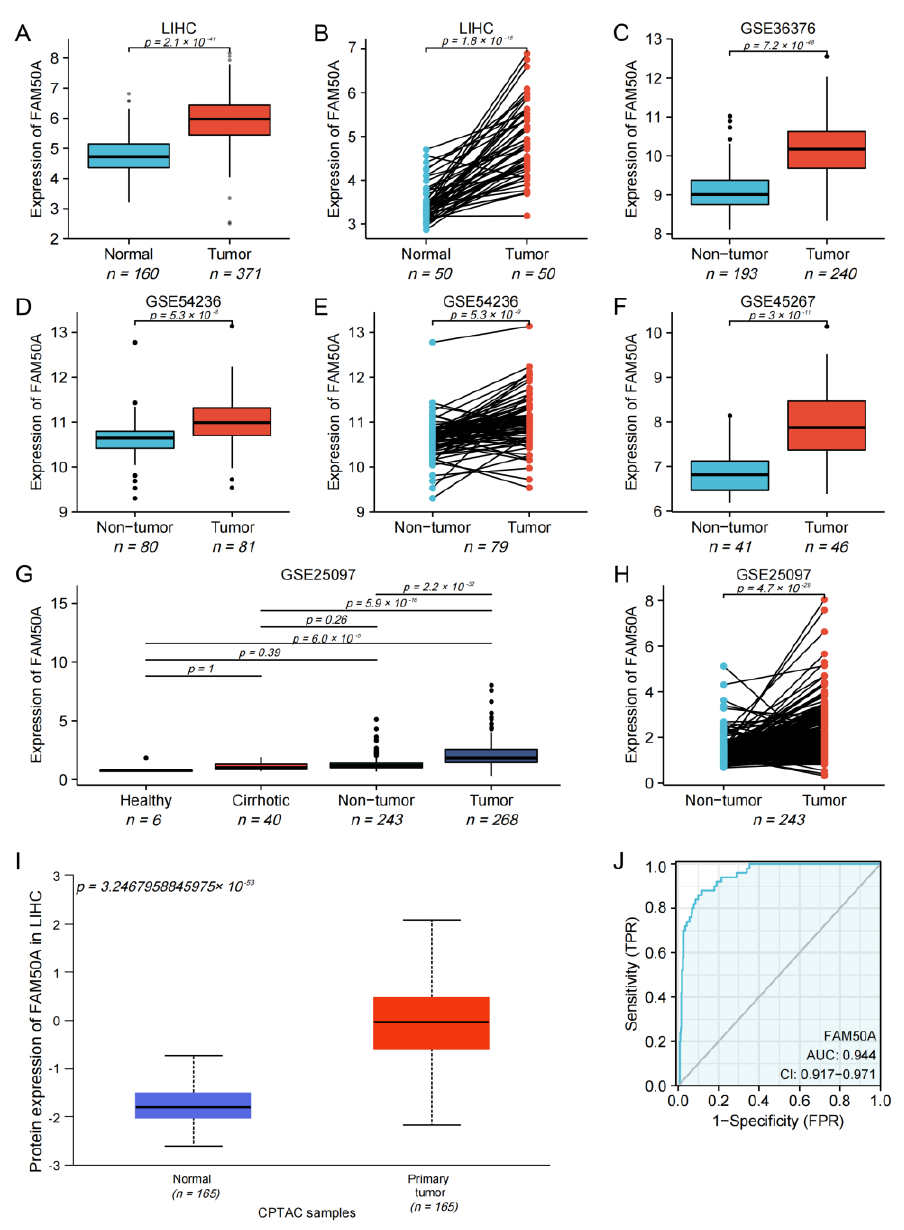
Figure 1. Expression and diagnostic efficacy of FAM50A in HCC. R software was used to perform Student’s t tests on data from multiple databases. The mRNA and protein levels of FAM50A in HCC tissues were higher than those in benign liver tissues. ( A ) Grouping comparison of RNA data from TCGA. ( B ) Paired comparison of RNA data from TCGA. ( C ) Grouping comparison of RNA data from GSE36376. ( D ) Grouping comparison of RNA data from GSE54236. ( E ) Paired comparison of RNA data from GSE54236. ( F ) Grouping comparison of RNA data from GSE45267. ( G ) Grouping comparison of RNA data from GSE25097. ( H ) Paired comparison of RNA data from GSE25097. ( I ) Grouping comparison of protein expression by UALCAN. ( J ) ROC analysis showed that the AUROC of FAM50A for HCC patients in the TCGA database was 0.944 and the CI was